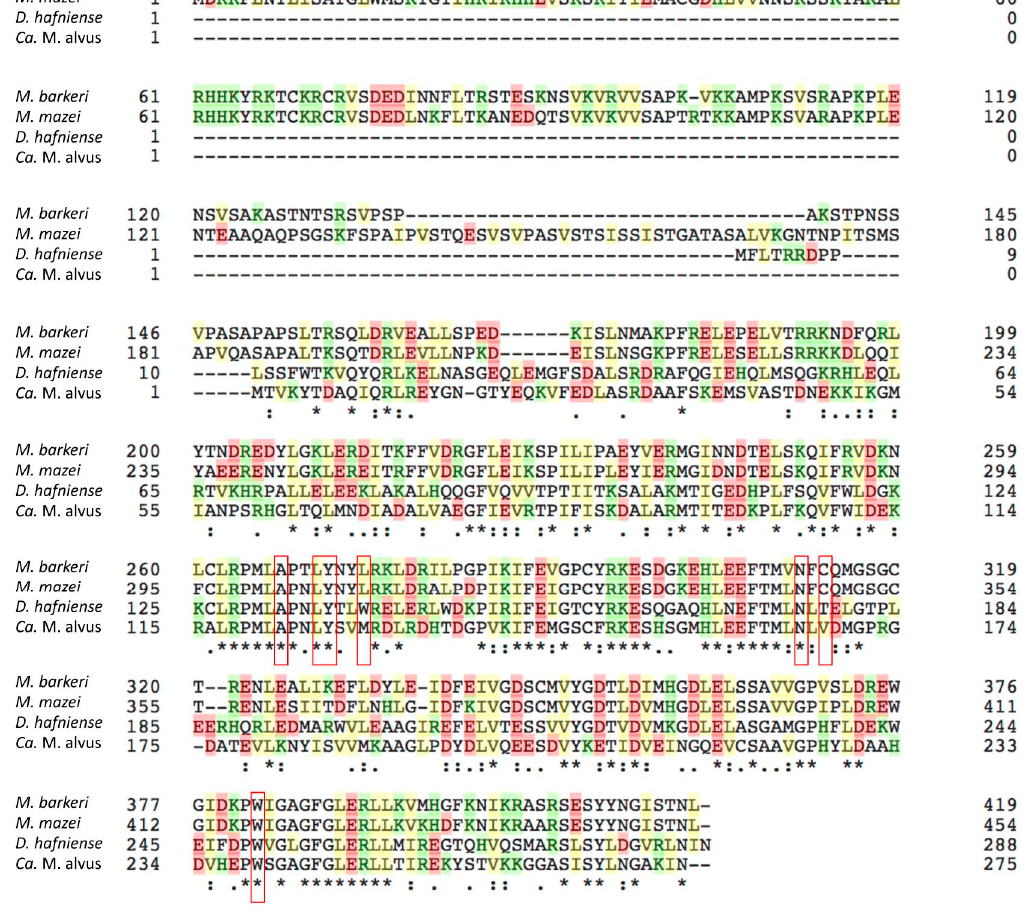
Figure 6. The alignment of the amino acid sequences of MmPylRS, MbPylRS, DhPylSc, and CMa PylRS. The residues at the pyrrolysine-binding pocket of MmPylRS and the corresponding residues in the other synthetases are indicated in the enclosures.